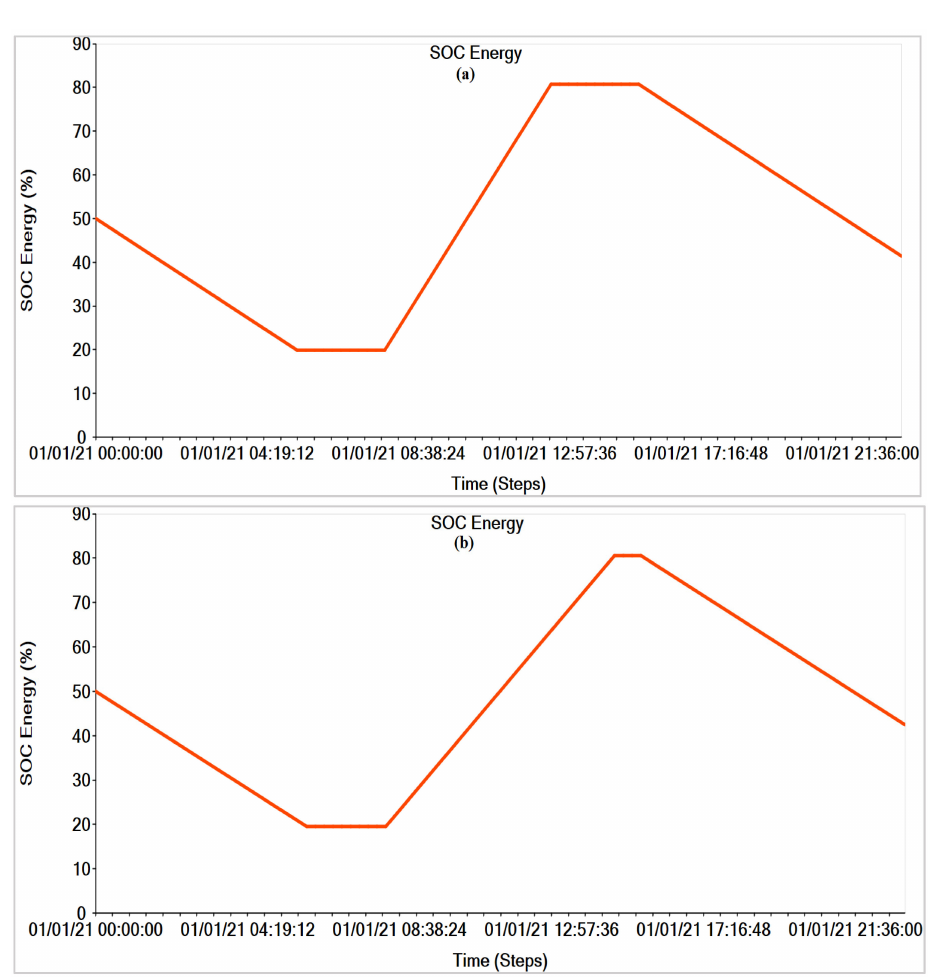
Figure 8. ( a ) Li-ion battery SoC and ( b )